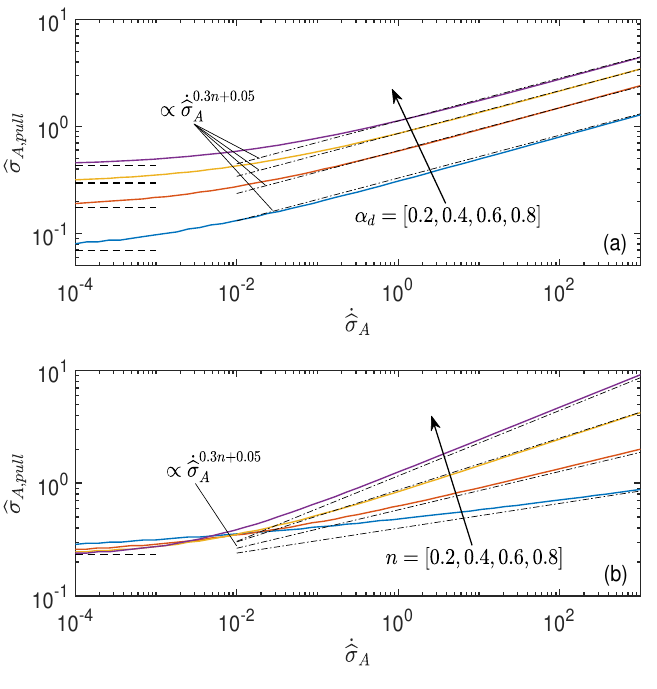
Figure 6. ( a ) Pull-off detachment stress (cid:98) σ A , pull as a function of the dimensionless unloading rate · (cid:98) σ A for α d = [ 0.2,0.4,0.6,0.8 ] and n = 0.5. ( b ) Pull-off detachment stress (cid:98) σ A , pull as a function of the · dimensionless unloading rate (cid:98) σ A for n = [ 0.2,0.4,0.6,0.8 ] , α d = 0.5. For all the curves, the initial condition is (cid:98) σ A = 0. In both panels, the black dashed lines indicate the Griffith equilibrium solution from Equation (7). Black dot-dashed lines serve as a guide to the